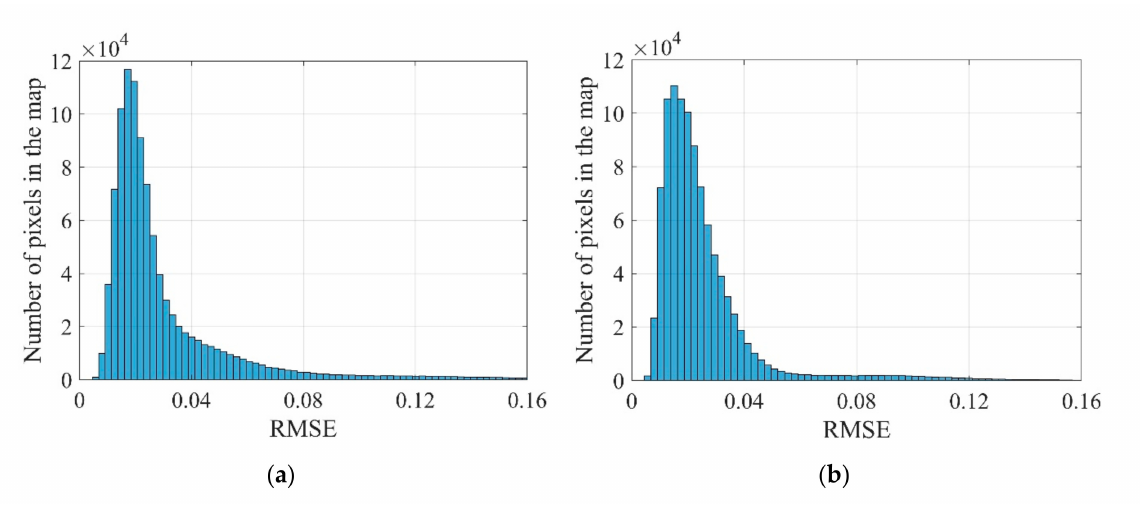
Figure 16. Histogram of 15 original images extracted from the time series and reconstructed by HANTS algorithm ( a ) and SSA algorithm ( b ).